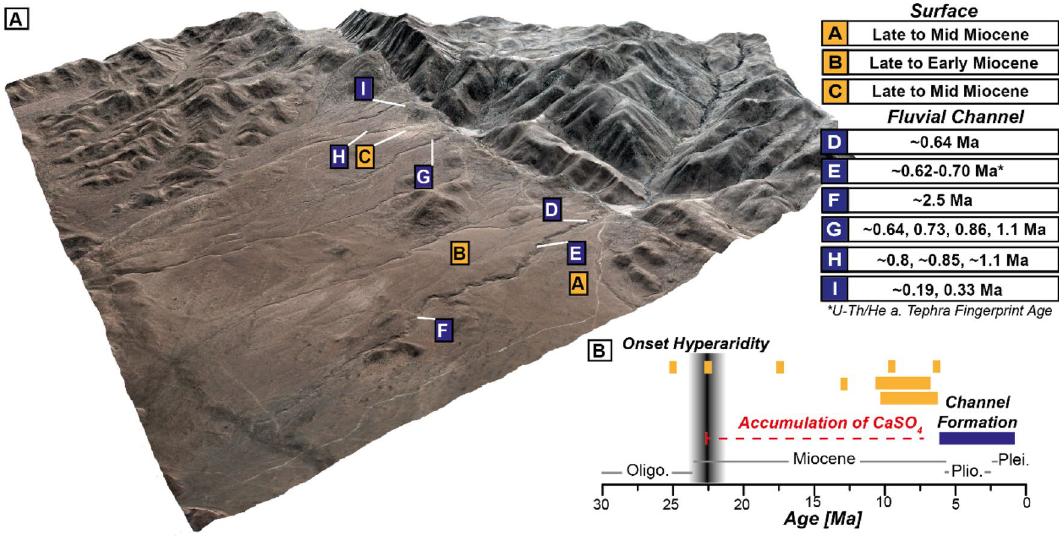
Figure 3. ( A ) 3D scene based on Pléiades 1B DEM and pansharped multispectral image created using ArcGIS Scene 10.5.1. Marked are sampling sites for dating, i.e., surfaces or channel beds. Compilation of age constrains for the landscape evolution of the sampling site, comprising 21 Ne ages for ancient Miocene surfaces, 10 Be ages for channel beds (multiple single clasts ages) and one age constraint based on geochemical fingerprinting of tephra layers. ( B ) Timeline for major landscape and climate evolution, comprising the early onset of hyperarid conditions at the Oligocene/Miocene boundary and the subsequent cessation of large deposition. Orange bars represent 21 Ne exposure ages and/or their age range. Blue bar indicates time period of sinuous to meandering channel formation based on exposure ages. Detailed information about exposure ages and probability density plots are reported in the Supplementary